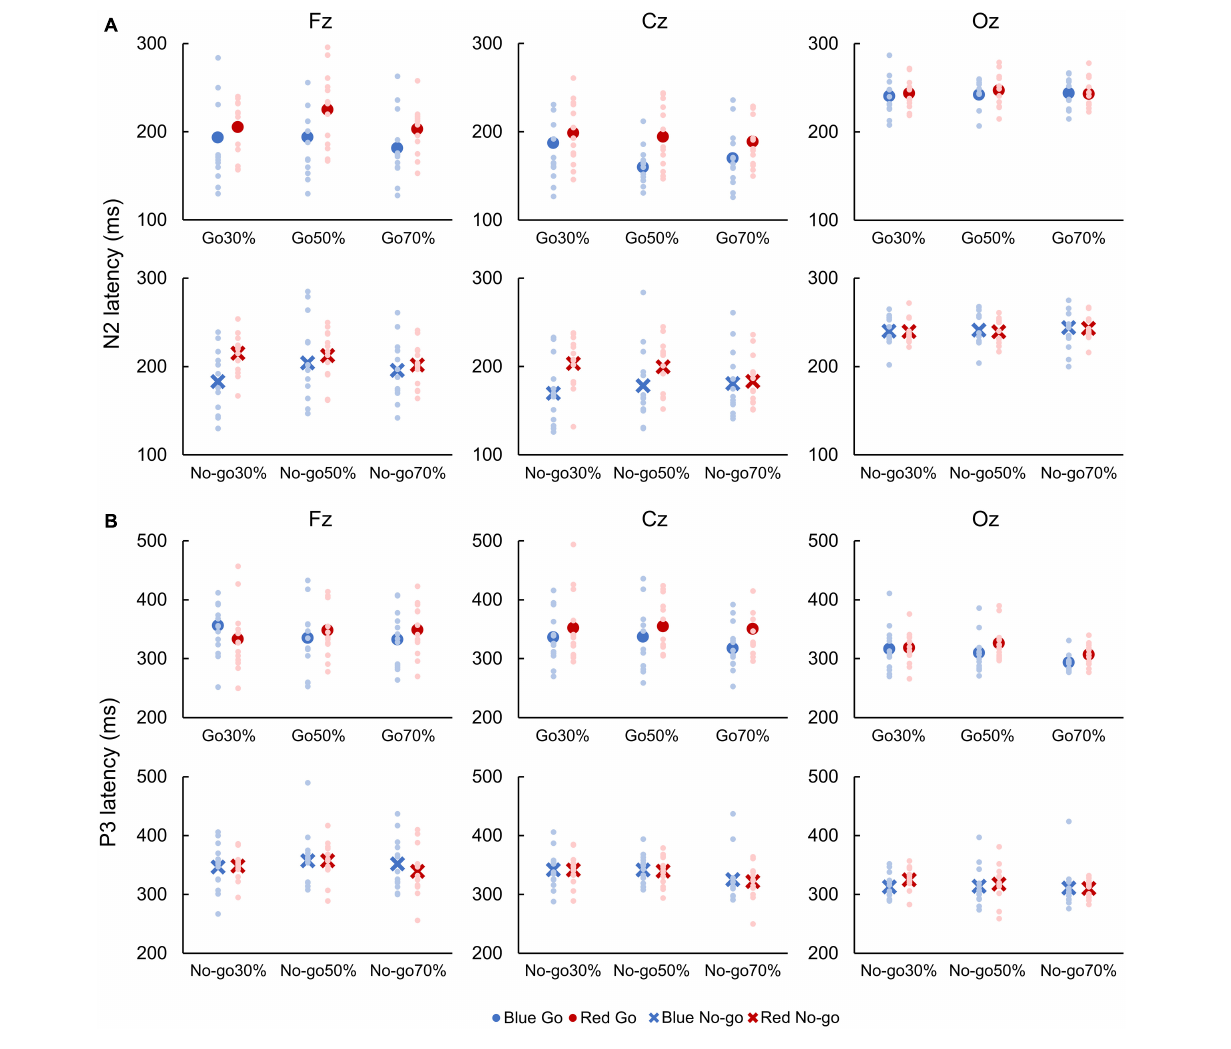
We found that the RT was faster in Blue Go than Red Go trial, and this result may be related to the Stroop effect (Stroop, 1935), in which the naming of written color words is impeded by the occurrence of different ink color. In a typical Stoop task with the conflict between a word name and its ink color, for instance, participants can respond faster to a letter “Red” printed in red than the one printed in blue. In addition, the Stroop-like effect has been reported using a conflict between color and shape of